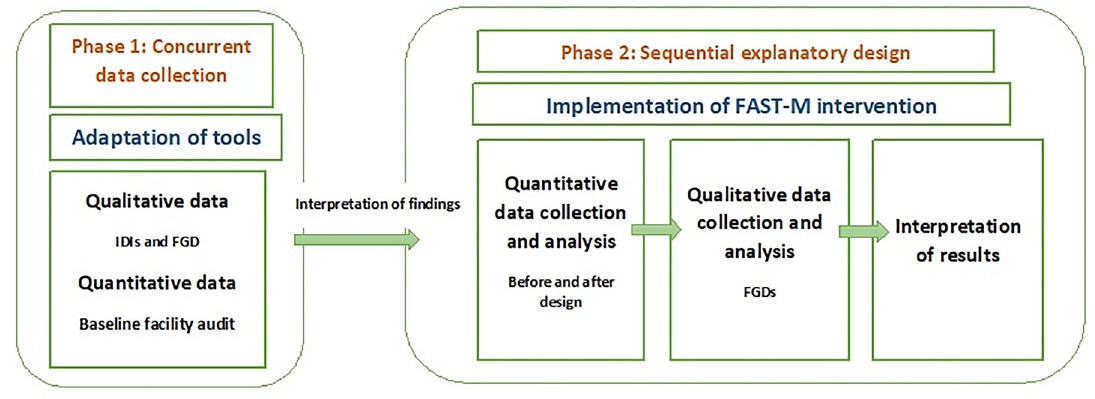
Fig 1. Flowchart displaying study processes.